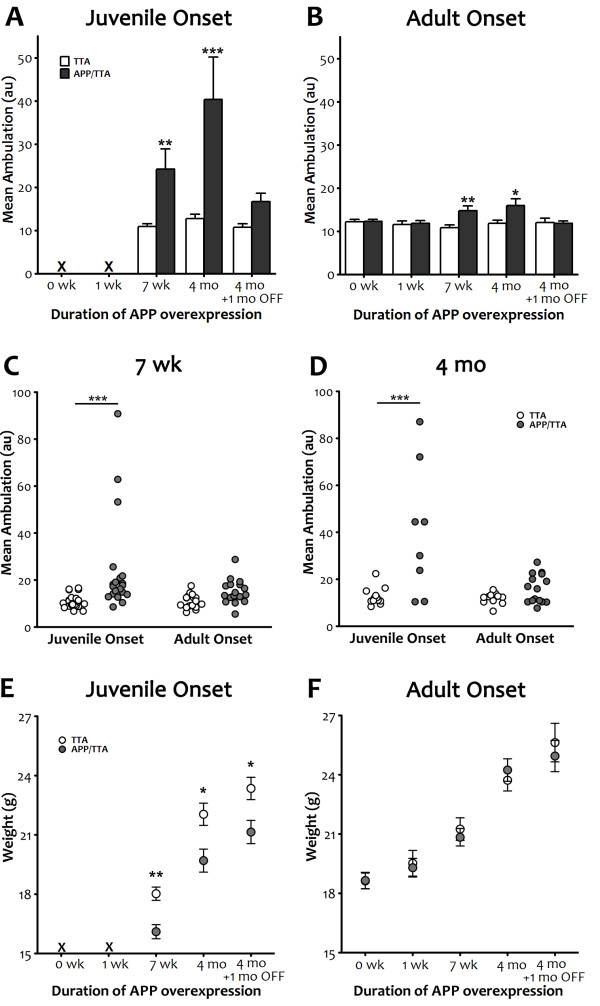
Delayed expression of transgenic APP reduces motor hyperactivity and normalizes body weight. A, B Comparison of mean ambulation recorded by infrared photobeam monitoring highlights the severity of hyperactivity observed in juvenile-onset APP transgenic animals (a) and the substantial reduction in this phenotype achieved by delaying onset until adulthood (b). Although reduced in magnitude with later onset, post-test analyses identified significant differences between genotypes for both adult- and juvenile-onset at 7 wk and 4 mo (**p < 0.01 for both at 7 wk; ***p < 0.001, for juvenile onset and *p < 0.05 for adult onset at 4 mo). C, D Replotting the data as individual values illustrates the wide range of locomotor activity seen in mice overexpressing APP from birth and the substantial decrease in both variance and average attained by delaying transgene onset. Individual mean ambulation is shown for juvenile vs. adult onset after 7 wk (C) and 4 mo (D) of transgenic APP expression. Post-test comparisons of groups matched for duration of expression magnifies the difference between genotypes for juvenile onset (***p < 0.001) but diminishes the difference for adult onset (p > 0.05 at both ages). E, F Mean body weight of APP-overexpressing mice is lower than controls at 7 wk (**p < 0.01) and 4 mo (*p < 0.05) in juvenile onset mice, and this difference persisted even after 1 mo of transgene suppression (*p < 0.05). Delaying transgene onset until adulthood normalized body weight of APP-overexpressing mice at all ages tested.